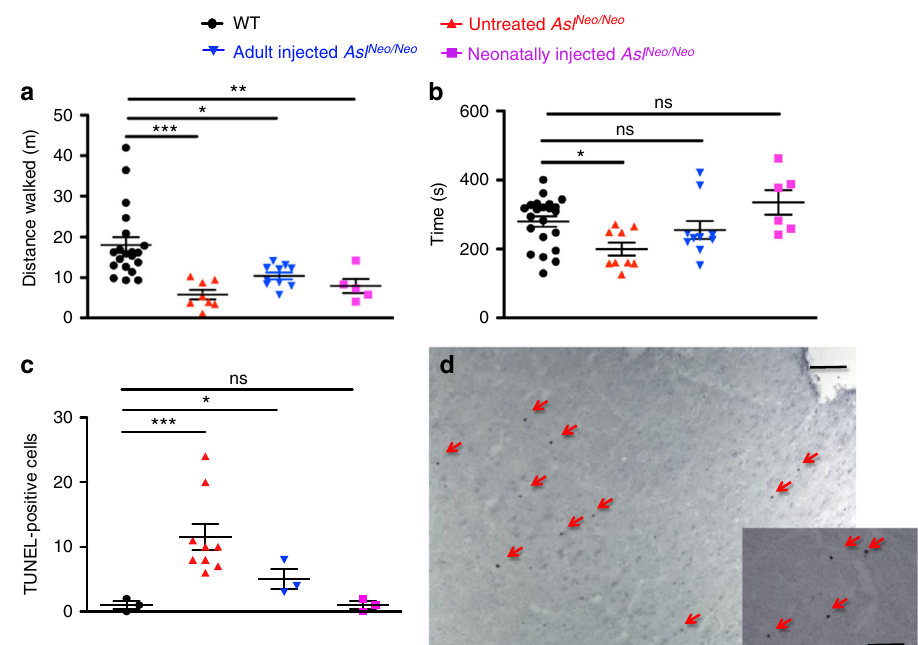
Fig. 6 AAV-mediated gene therapy improves behavioural testing and is inversely correlated with cortical neuronal loss in treated animals. a Open fi eld test and b accelerating rotarod performed in 2-month-old mice. c , d Apoptotic cells at time of culling in WT (aged 9 – 13 months), untreated (aged 21 days − 13 months), adult-injected (aged 13 months) and neonatally injected Asl Neo/Neo mice (aged 9 months). c Cell counting in cortex. d Representative cortex image of an untreated 25-day-old Asl Neo/Neo mouse symptomatic of hyperammonaemia and culled for humane endpoint. Horizontal lines display the mean ± SEM. a , b One-way ANOVA with Dunnett ’ s post-test compared to WT: ns — not signi fi cant, * p < 0.05, ** p < 0.01, *** p < 0.001. c Graph displays not transformed data. Statistical analysis used log-transformed data. WT n = 20 – 22; untreated Asl Neo/Neo n = 8 – 9; adult-injected Asl Neo/Neo n = 5; neonatally injected Asl Neo/Neo n = 5. Scale bars: 500 μ m and 125 μ m in main and inset pictures,